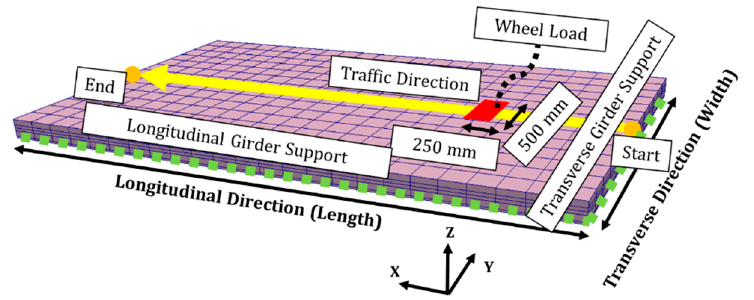
Figure 5. Standardized state of the RC deck discussed.